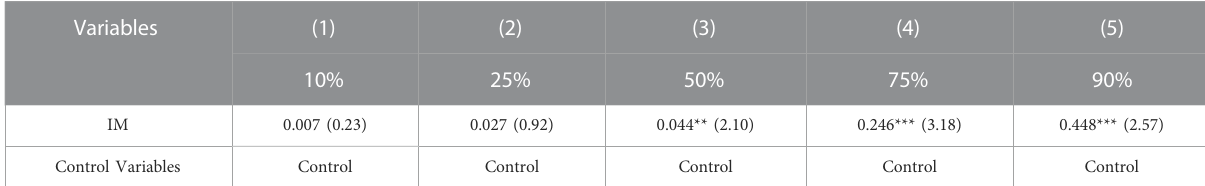
TABLE 4 Results of the panel quantile model.